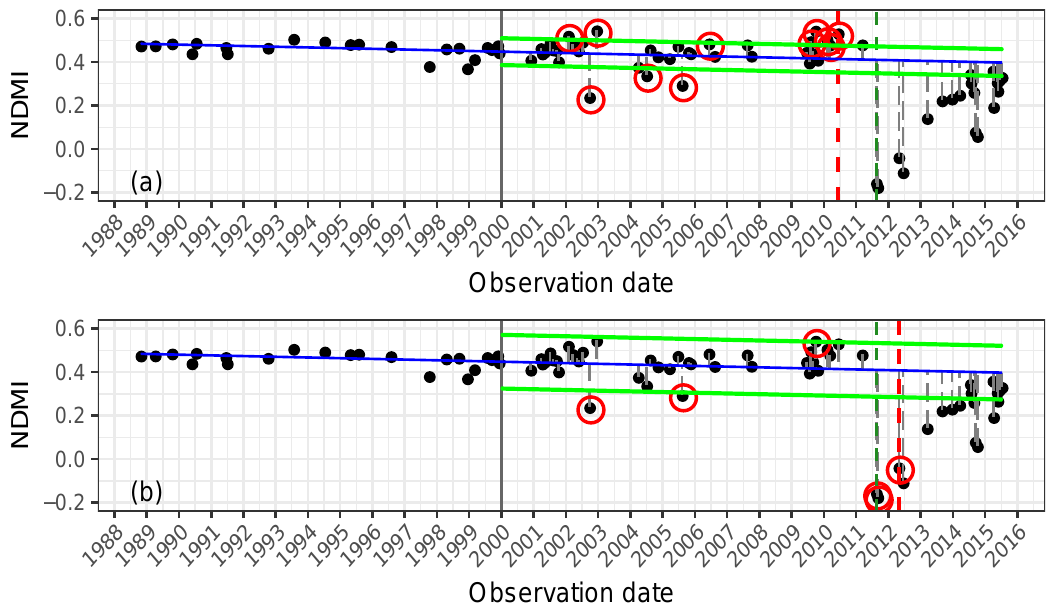
Figure 2. Demonstration of the deforestation detection algorithm. The solid green lines denote prediction ± boundary i.e., prediction ± k × RMSE history . k = 2 in ( a ), while k = 4 in ( b ). The vertical black line denotes the start of monitoring. The vertical dashed red line is change event declared by the algorithm. The vertical dashed green line denotes reference date of deforestation event. The solid blue line is the ordinary linear regression model fit to historical observations i.e., points to the left of vertical black line. Vertical dashed grey lines denote the monitoring period residual. NDMI is the normalized difference moisture index calculated from Landsat data. The points circled in red are the potential, but not necessarily confirmed, deforestation events based on the consecutive anomalies criterion. The time series observations are from all TM, ETM+, and OLI sensors, from a pixel (118.0327 ◦ E, 2.3049 ◦ N) showing forests which were cleared in 2011 and subsequently converted into oil palm